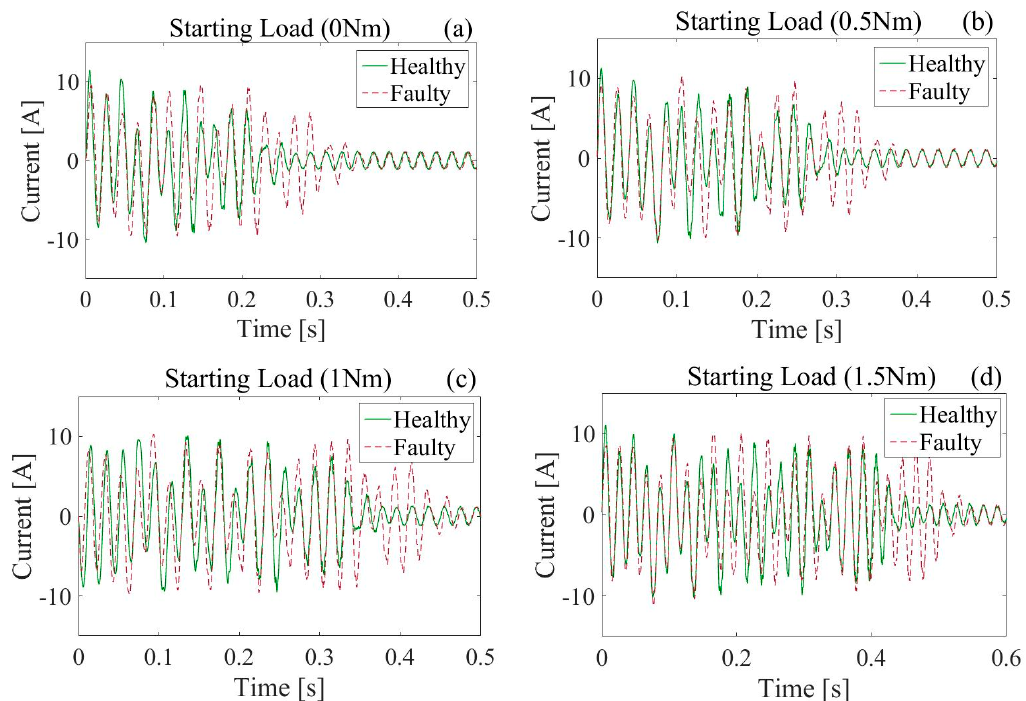
Figure 14. Experimental current signal in four load conditions for healthy and faulty motors.